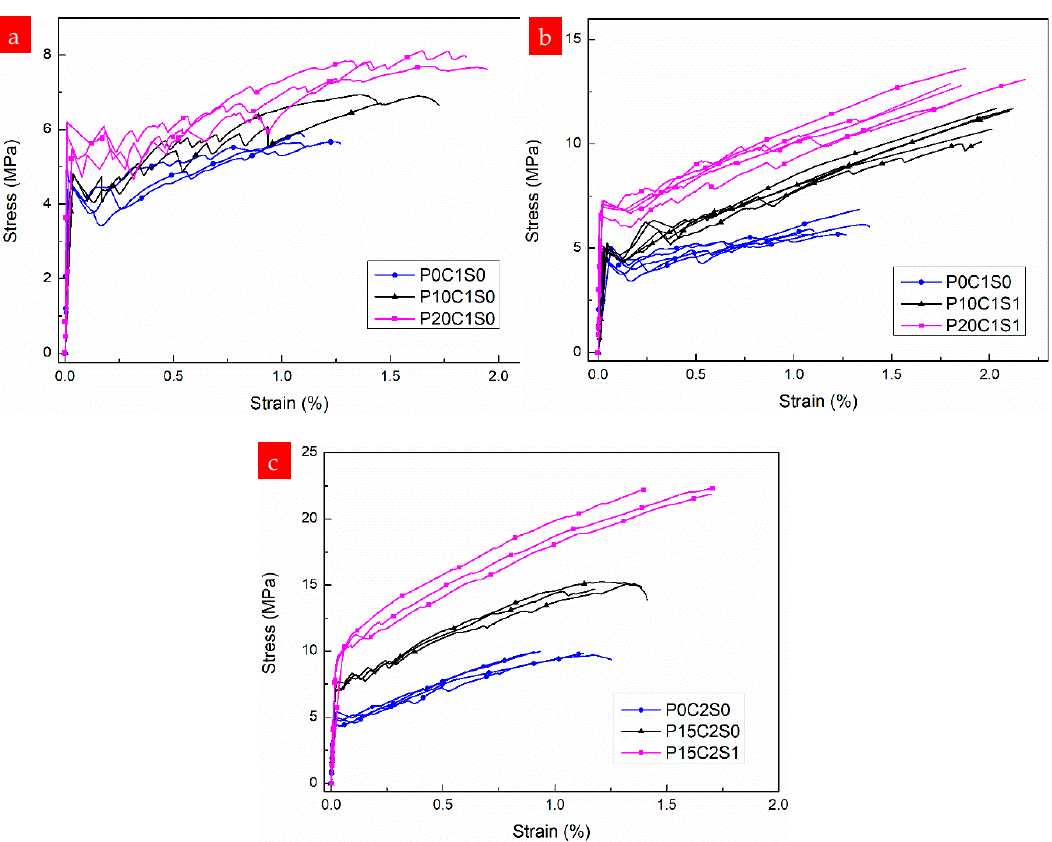
Figure 18. Stress–strain curves of the prestressed TRM specimens: ( a ) reinforced with one-layer textile and without steel fibers, ( b ) reinforced with one-layer textile and 1.0% steel fibers, and ( c ) reinforced with two-layer textiles.